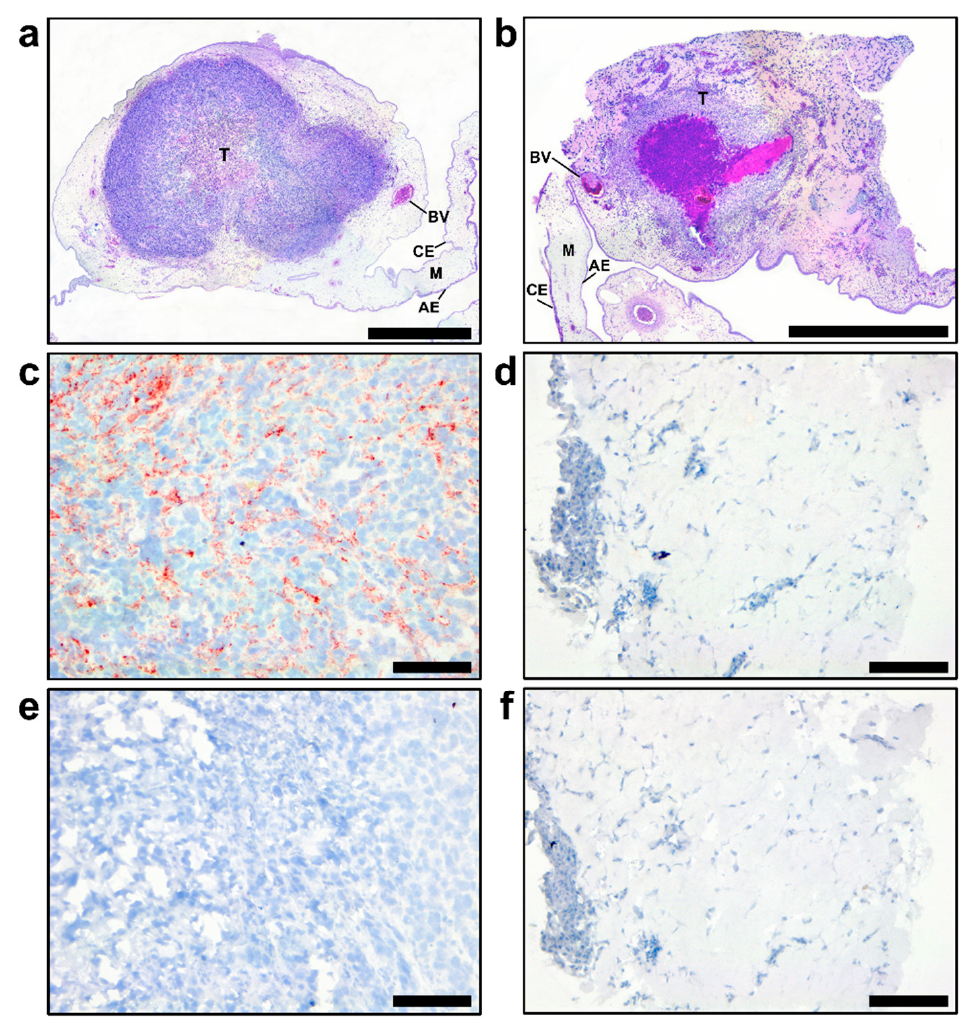
Figure 4. Hematoxylin and eosine staining in glioblastoma stem cells (GSC 528 ( a ) and GSC 157 ( b ) tumors at day 19 of embryonic development. CE: chorionic epithelium, AE: allantoic epithelium, M: intermediate vascularized mesenchyme, BV: blood vessel, and T: tumor. TGM2 ( c : GSC 528; d : GSC 157) and SOX2 ( e : GSC 528; f : GSC 157) protein expression in tumor cells; TGM2-positive staining is in red ( c ). Scale bars are 1 ( a , b ) and 0.1 mm ( c – f ).